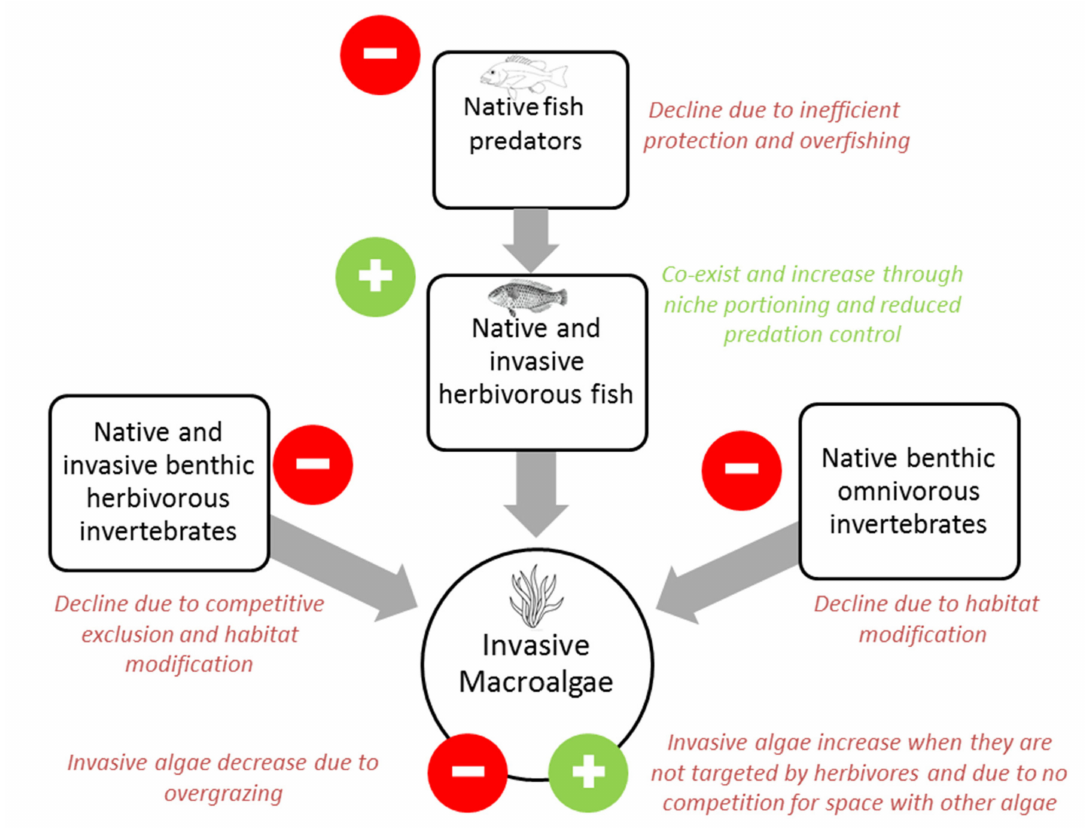
Figure 3. Schematic representation of the long term interactions between and within the native and invasive species in a Mediterranean MPA ( − sign stands for a decline in the occupancy and + sing for an